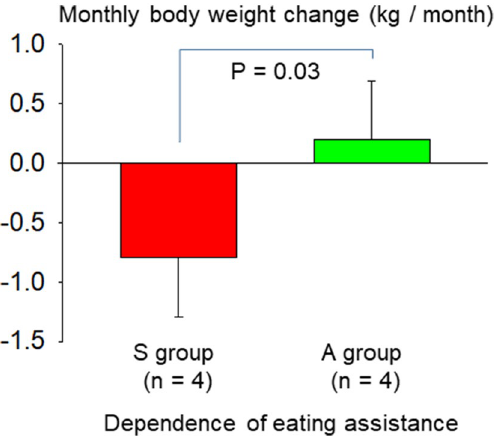
Figure 1. Comparison of monthly weight change between nursing home residents with (A-group) and without (S-group) eating